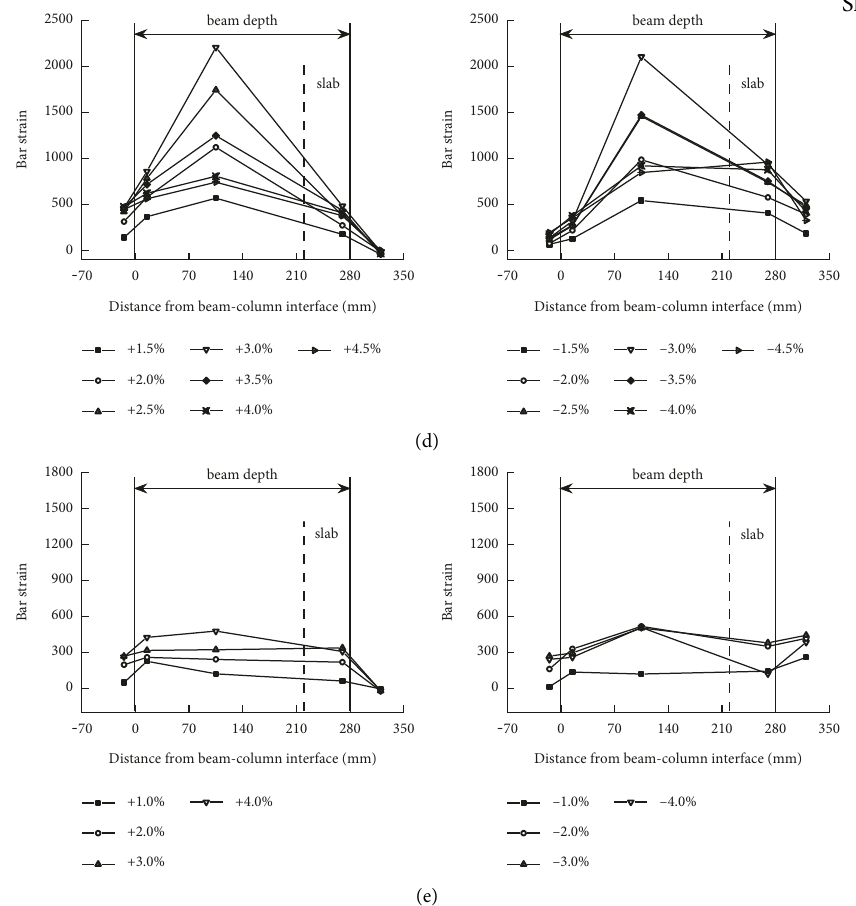
Figure 9: Strain variation of hoop near core. (a) EBCJ1. (b) EBCJ2. (c) EBCSJ1. (d) EBCSJ2. (e)